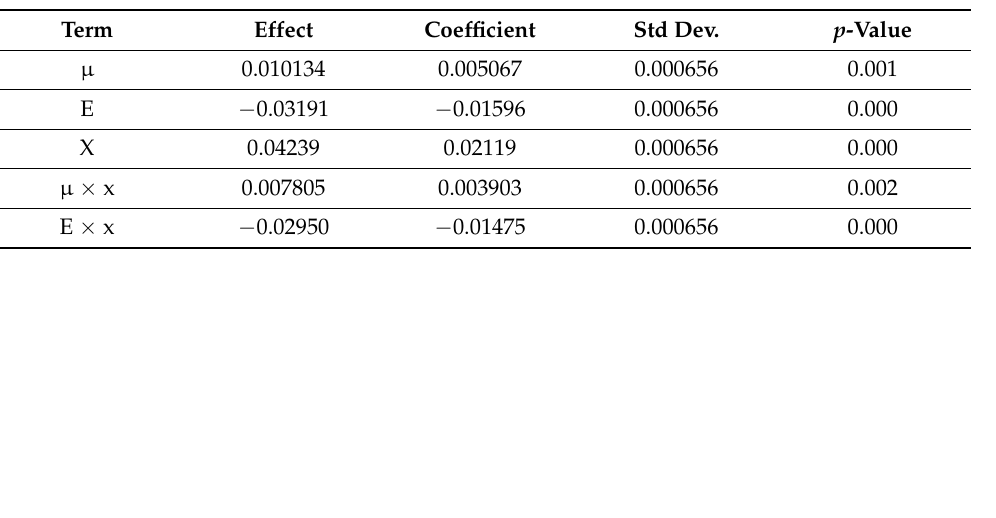
Table 7. Analysis of